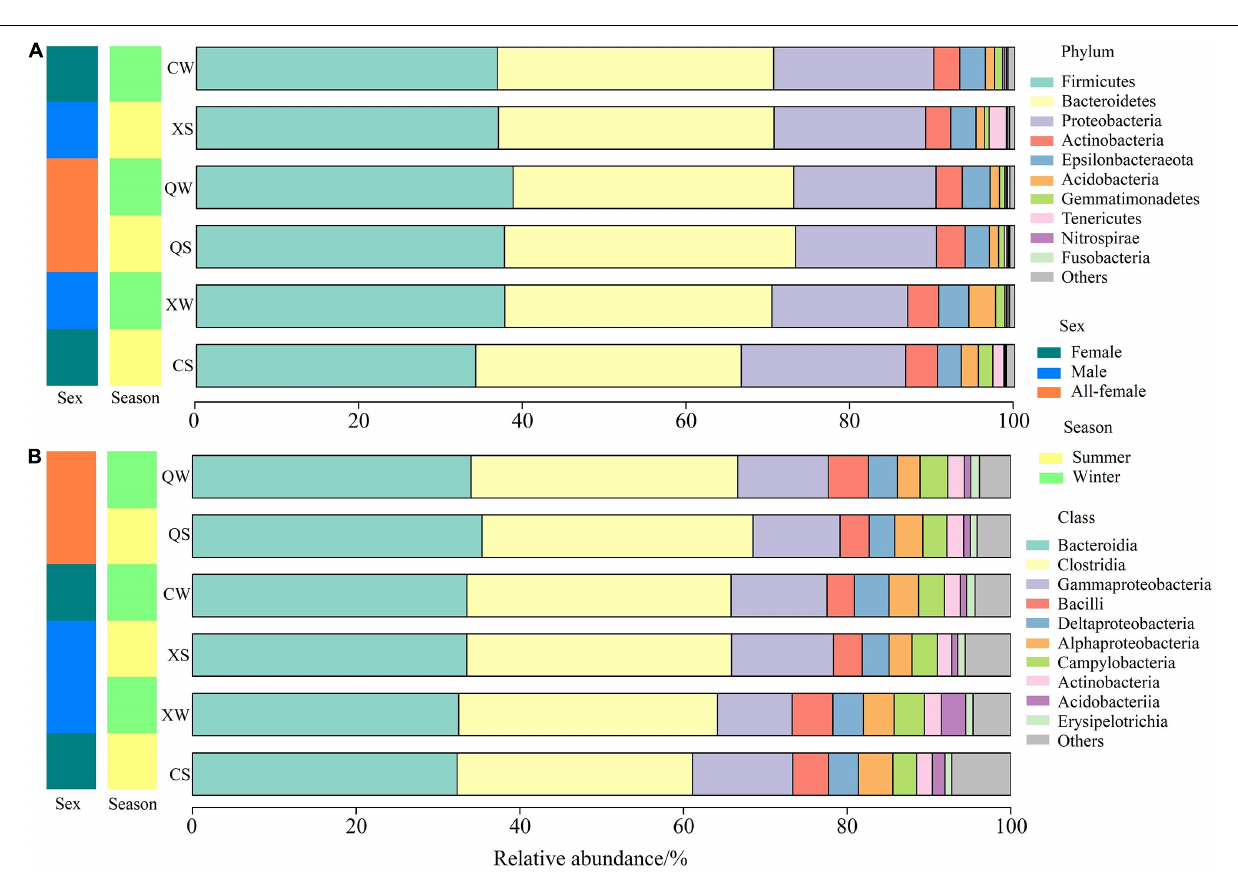
groups ( Supplementary Figure 4 and Supplementary Table 7